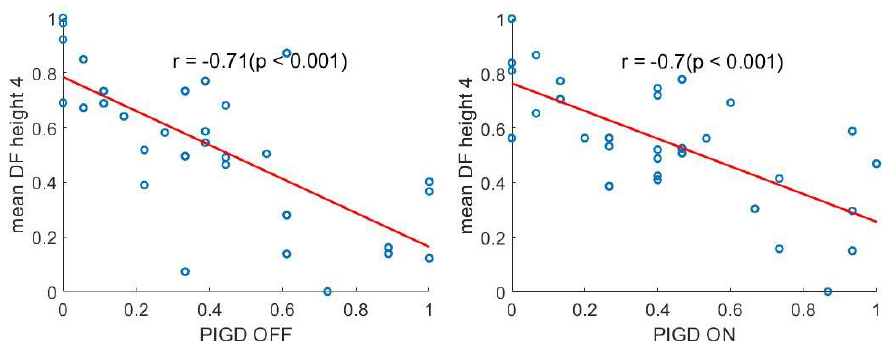
Figure 6. Correlation plot between the average principal harmonic height for the x -axis angular velocity (DH height 4) and PIGD score. Data and PIGD score refer to patients OFF ( left ) and ON ( right ) therapy. PIGD: postural instability and gait